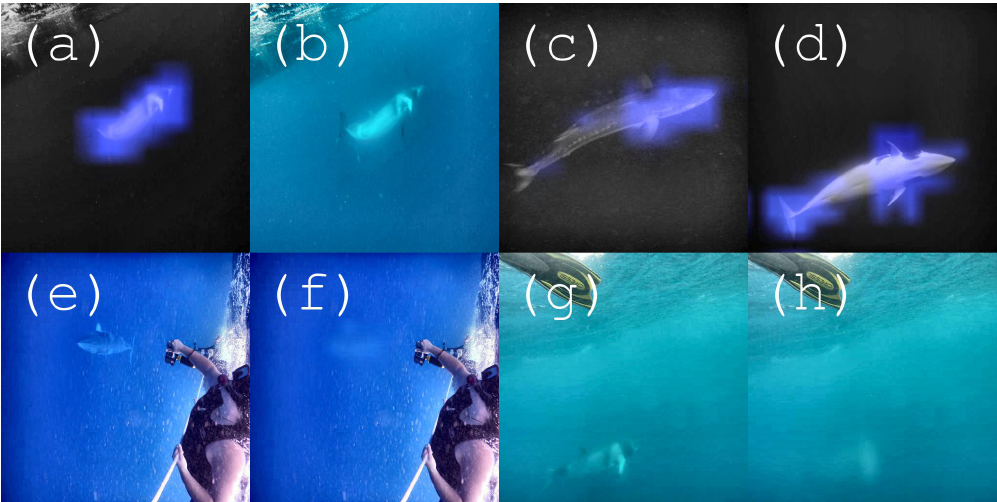
Figure 4. Sub-figures: ( a , c , d ) are examples of localisation by MWD; ( b ) is the corresponding original for ( a ); ( f , h ) are examples of the negative-labelling technique, where the corresponding original images are ( e ) and ( g ),